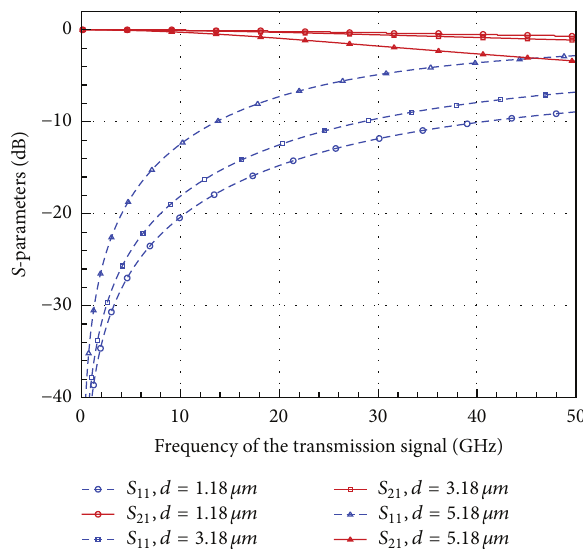
Figure 9: HFSS simulations results of the switch in ON state.